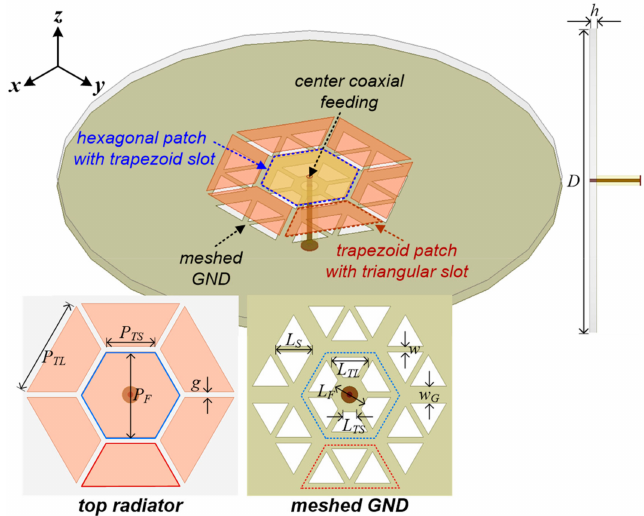
Figure 1. The proposed antenna with a cross-sectional view, an enlarged top radiator, and a bottom mesh ground